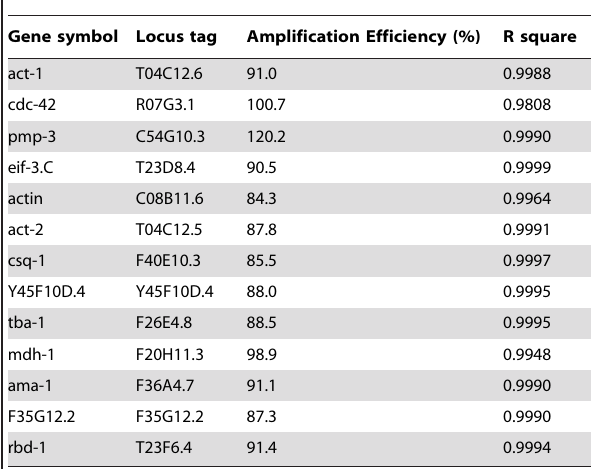
Table 2. Primer amplification efficiency of the thirteen candidate reference